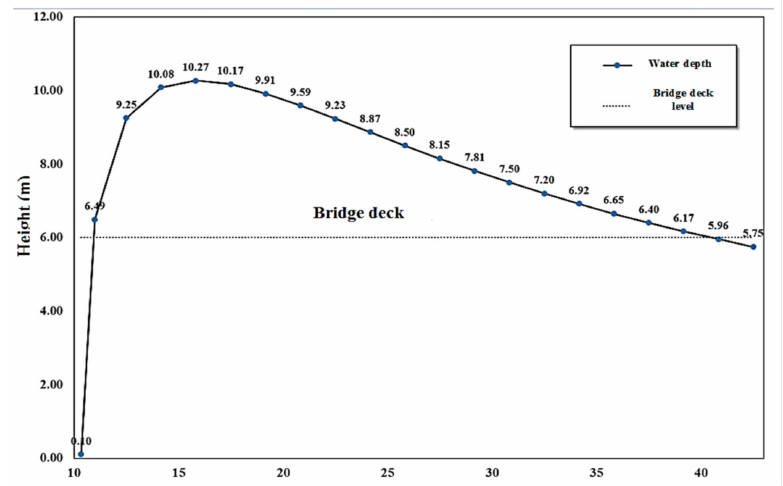
Figure 20. Water level variations at the B1